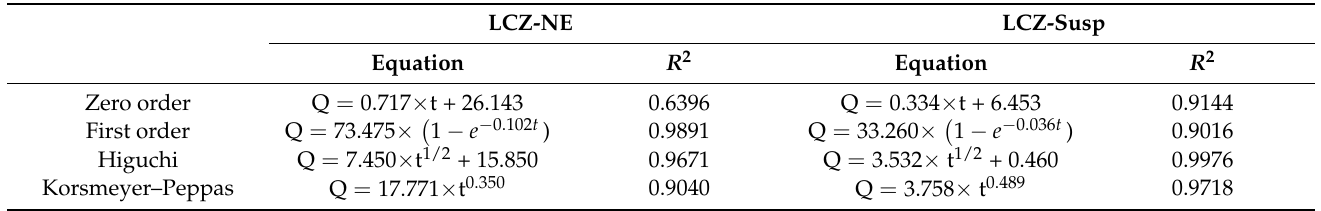
Table 3. The squared correlation coefficients ( R 2 ) and equations for the different mathematical models fitted to the release of